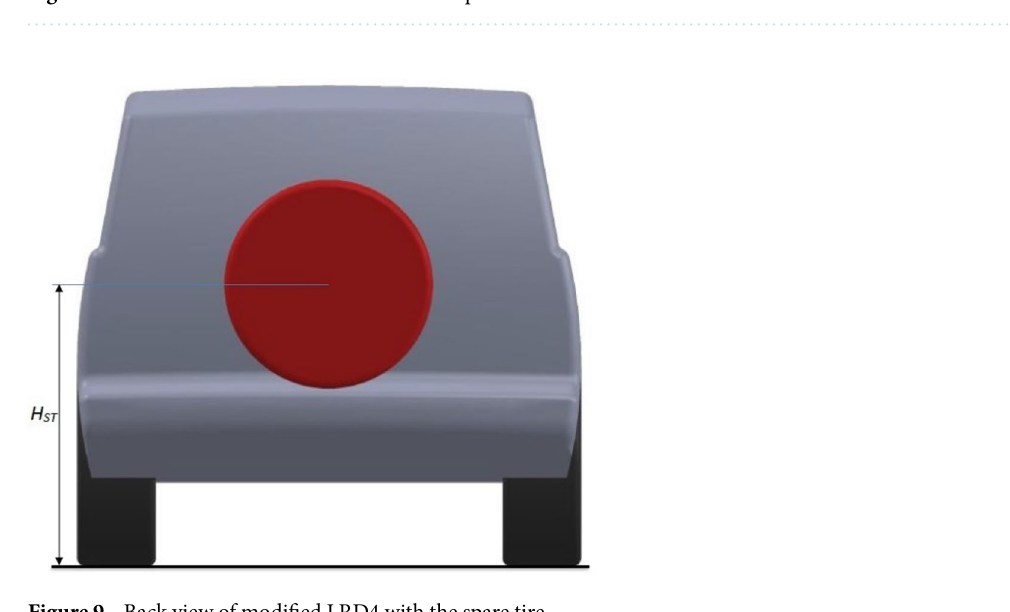
Figure 9. Back view of modified LRD4 with the spare tire.